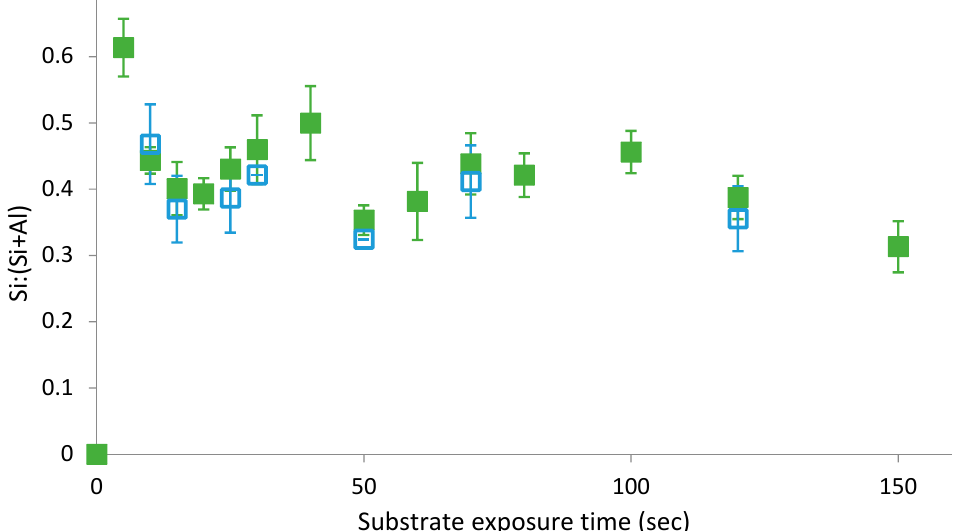
Figure 6. Oscillatory adsorption of 1% PTMS in 1:1 EtOH:H 2 O solvent at pH3 on aluminium foil substrate measured using XPS. Upon removal from solution, films were cured ( solid green squares ) [8], measured using XPS, rinsed with pH3 CH 3 COOH ( open blue squares ) and measured